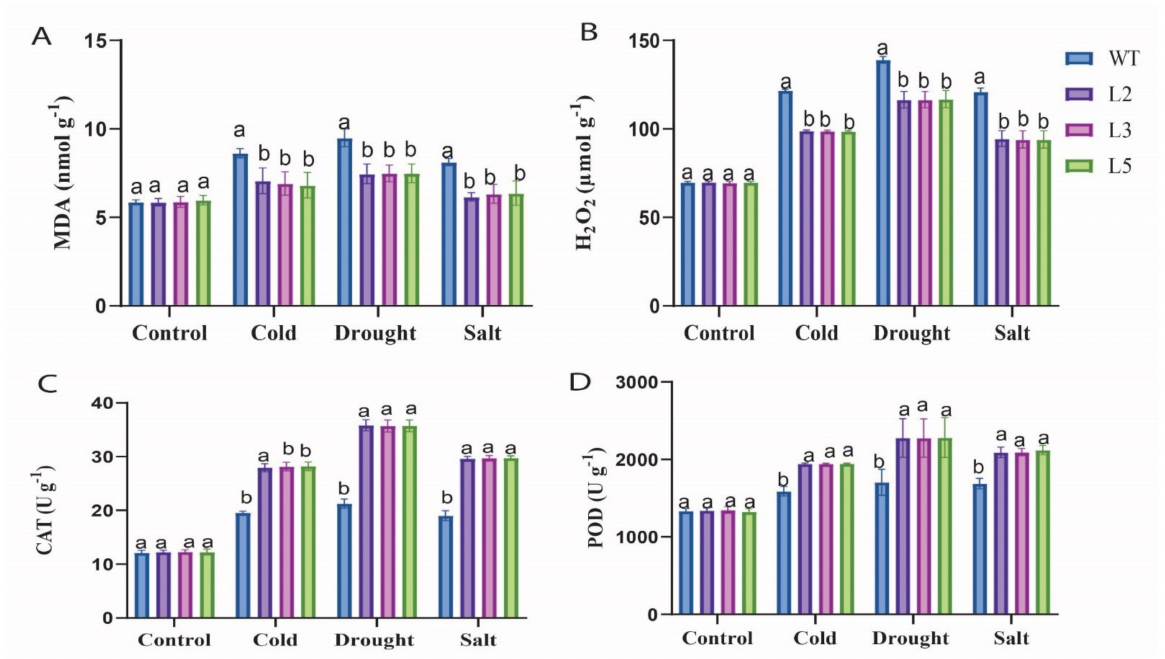
Figure 6. Determination of enzyme activity in GhMPK3- overexpressed and WT plants induced by stress treatments. ( A ) Malondialdehyde (MDA), ( B ) Hydrogen peroxide (H 2 O 2 ), ( C ) Catalase (CAT), and ( D ) Peroxidase (POD) in post-treatment. Three replications were conducted in each experiment. The bar indicates a standard error (SE). “a” and “b” indicates major variations between the columns (ANOVA, p < 0.05). WT: Wild type. L2, L3, L5: Overexpressed lines.